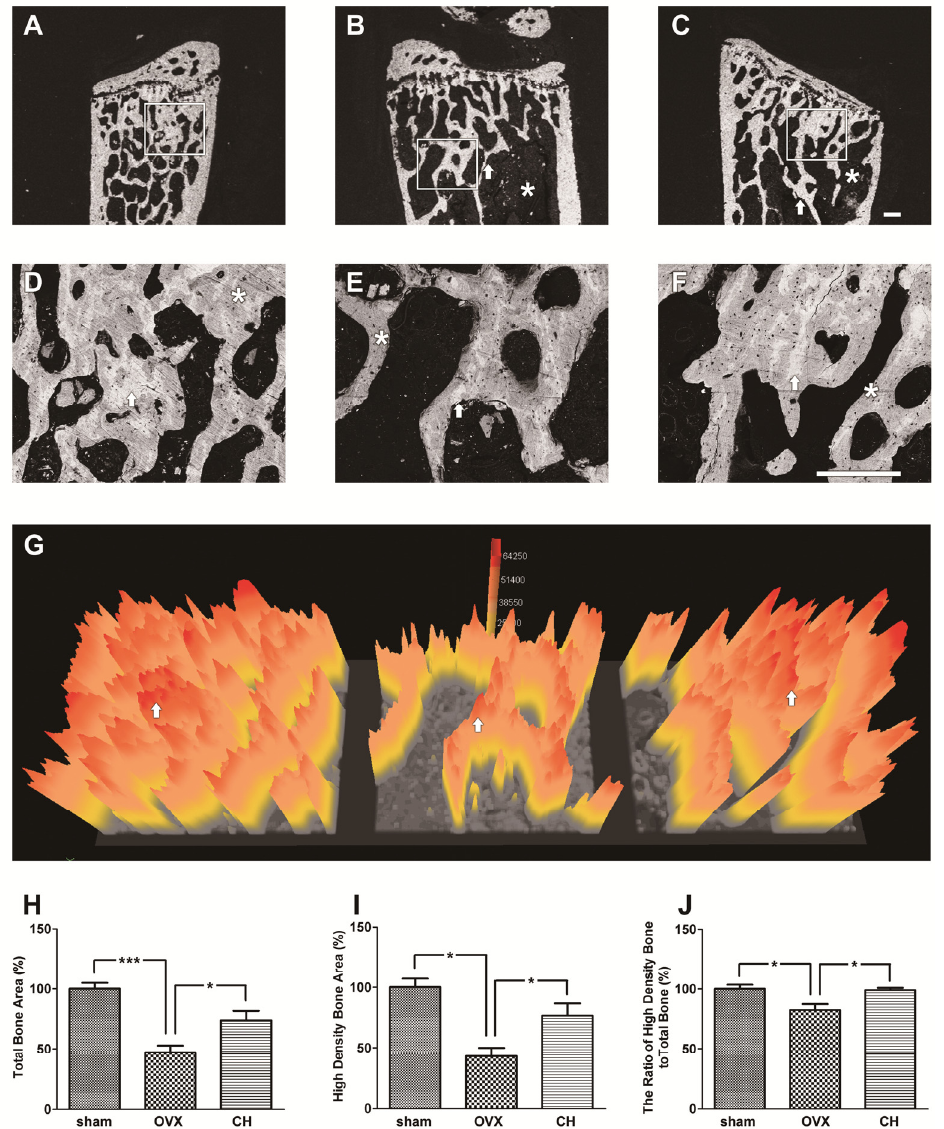
Figure 7. ( A – F ) Backscattered electron (BSE) microscopic images of lumbar vertebrae, and ( G ) 3D bone density map. ( A , D ) Sham group showed highly dense trabecular bone mass phenotype. ( B , E ) OVX group showed low trabecular bone mass phenotype. Arrow showed thinner trabecular bone and there was a massive empty space ( * ) in cancellous bone. ( C , F ) CH treated group showed a thicker trabecular bone compared with OVX and the empty space ( * ) was smaller than OVX. The D , E , and F were enlarged from the square areas of A , B , and C , respectively. Arrows and asterisks ( * ) in D, E, and F were the high density bone areas and the low density bone areas, respectively. Scale bar = 300 μ m. ( G ) The image shows a bone density map. The high bone density area (white area pointed by arrows in D , E , and F ) were represented as red color. Yellow color represented the total bone area. Arrows depicted in G were the same areas pointed by arrows in D , E , and F . ( H ) The ratio of total bone area in BSE images. ( I ) The ratio of high density bone area. ( J ) The ratio of high density bone area to total bone area. Data are expressed as means ± SEM. * p < 0.05 vs. OVX. *** p < 0.01 vs.